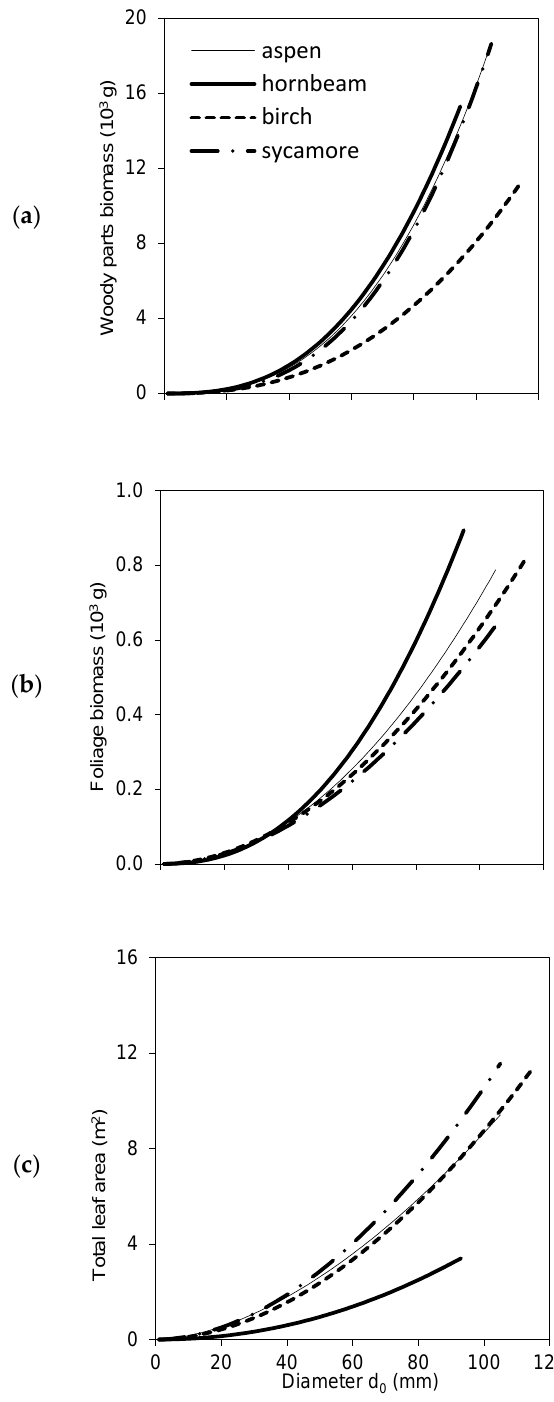
Figure 3. Species-specific models for woody parts biomass ( a ), foliage biomass ( b ) and leaf area at a tree level ( c ) against diameter d 0 (see Tables 3 and 4 for parameters and statistical characteristics of parameters).